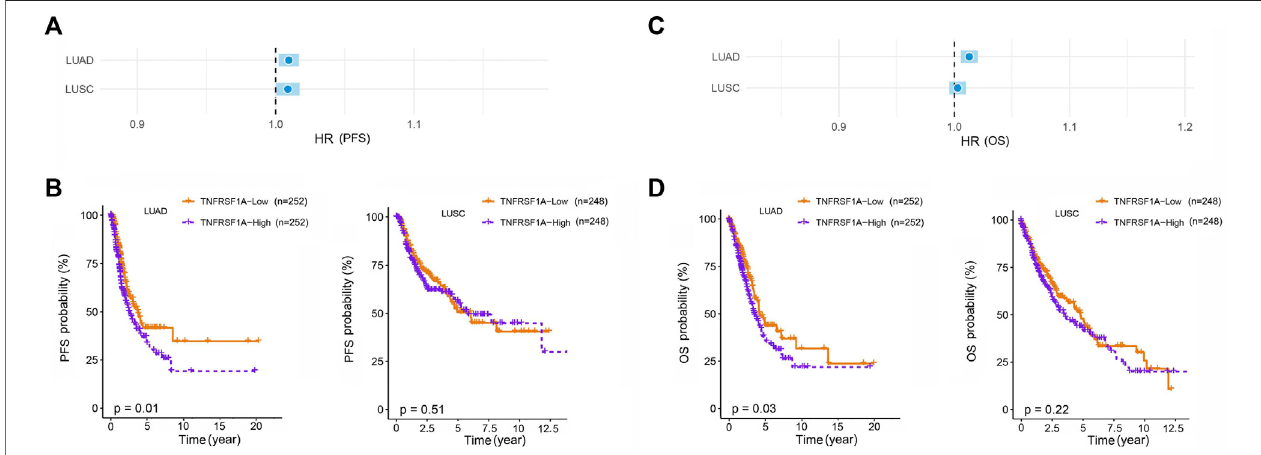
FIGURE4| Associationoftheexpressionof TNFRSF1A withlungcancerprognosisinpatientswithLUAD(Lungadenocarcinoma)andLUSC(Lungsquamouscell carcinoma). Low expression of TNFRSF1A in patients with LUAD was associated with signi fi cantly longer (A,B) progression-free survival (PFS) and overall survival (C,D)